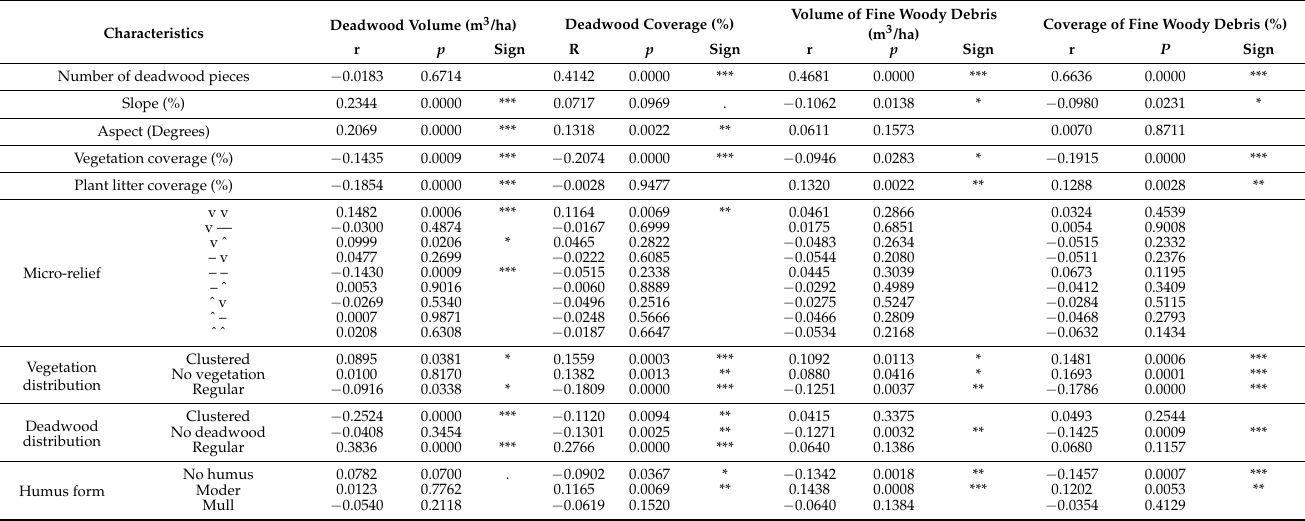
Table 2. Correlation of deadwood volume and coverage with site characteristics determined by Pearson’s correlation coefficients.